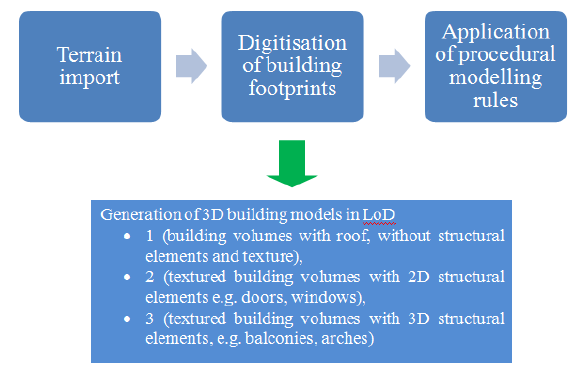
Figure 5. Generation of 3D model – workflow